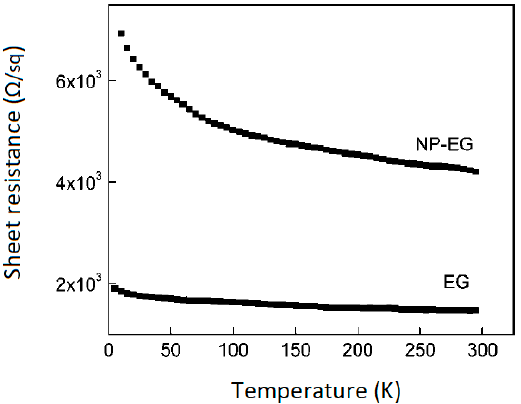
Figure 15. Temperature dependent sheet resistance of EG on SiC(000 1(cid:3364) ) and nitrophenyl functionalized graphene (NP-EG). Reprinted with permission from Reference [132]. Copyright (2009) American